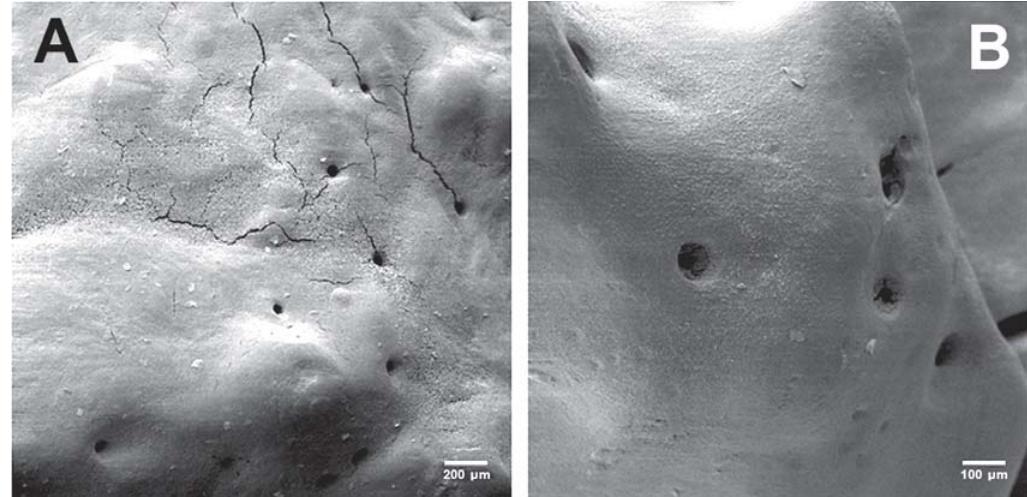
FIGURE 5- Focal hypercementosis. (A) Morphologic aspects of the foramina located in the distobuccal root of a maxillary molar. (B) Openings of the foramina at the middle third at the mesiobuccal surface of a maxillary canine. Original magnifications: (A) ×100, (B) ×50